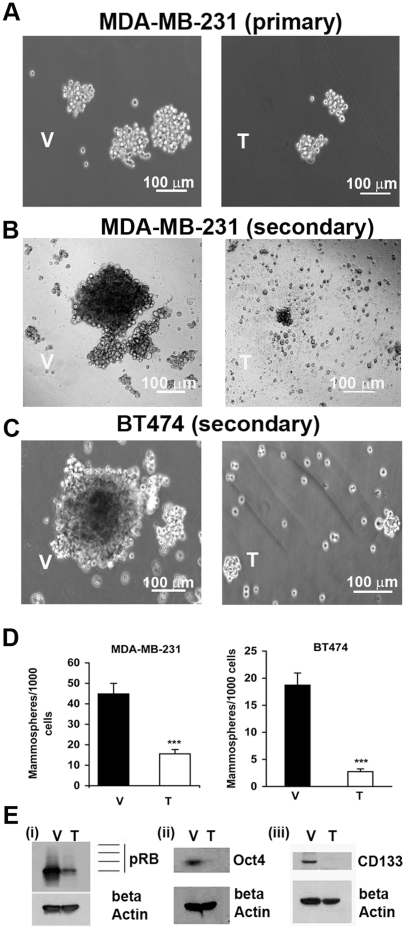
Tranilast treatment reduces mammosphere formation and stem cell marker expression.A. Tranilast (200 µM) markedly reduced the number of primary mammospheres of MDA-MB-231 cell line when compared to the vehicle control (results at d 7) (100X). B. Similar results were obtained in MDA-MB-231 secondary mammosphere culture. C. Tranilast (200 µM) markedly reduced the numbers and size of secondary mammospheres (results at d 14) of the BT474 cell line (100X). D. Tranilast caused a significant reduction of mammosphere numbers related to the number of cells plated as described in Fig. 2A and 2C (mean + SD; ***p<0.0001). Results are the mean of 2 independent experiments in triplicates. The mean diameter of the mammospheres in tranilast cultures was significantly less than half that of vehicle cultures (not shown). Scale bar: 100 µm. E,i. Western blots of MDA-MB-231 cell lysates of primary mammospheres show that phosphorylated retinoblastoma protein (denoted here pRB) was greatly reduced by tranilast. E, ii, iii. Western blots show complete suppression of the stem cell markers Oct 4 and CD133 by tranilast. The data presented in Fig. 2A–E were all derived from cells grown under mammosphere culture conditions with 200 µM tranilast or vehicle. V  =  vehicle; T  =  tranilast.